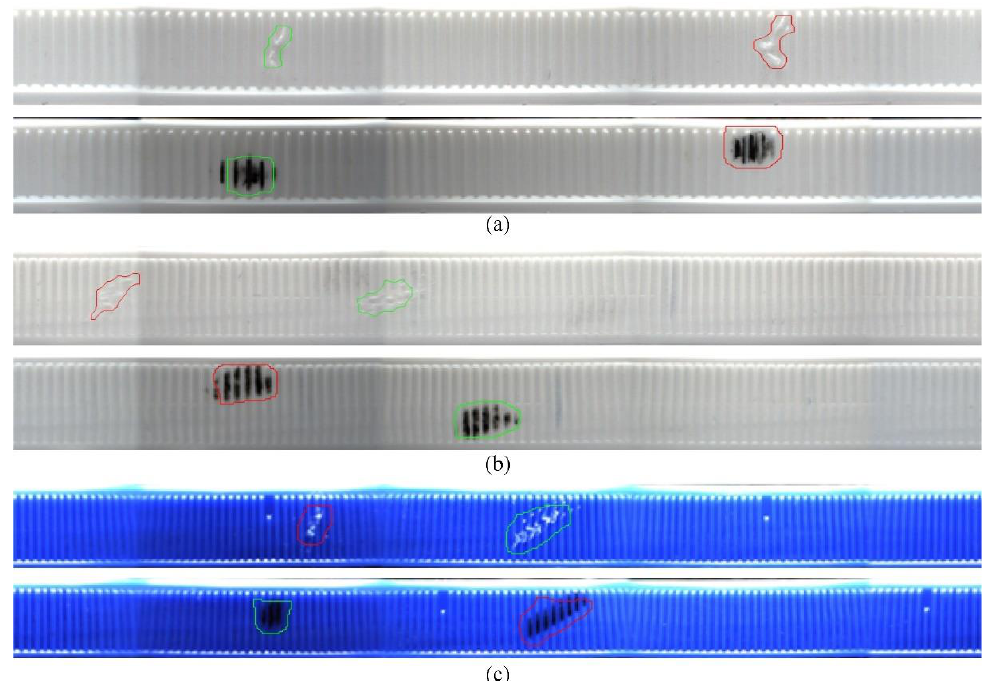
Figure 16. The defect detection results for three stitched sample images using FISA algorithm: ( a ) The defect detection results of scratch and oil stain defects on sample 1; ( b ) The defect detection results of scratch and oil stain on sample 2; ( c ) The defect detection results of scratch and oil stain on sample 3.